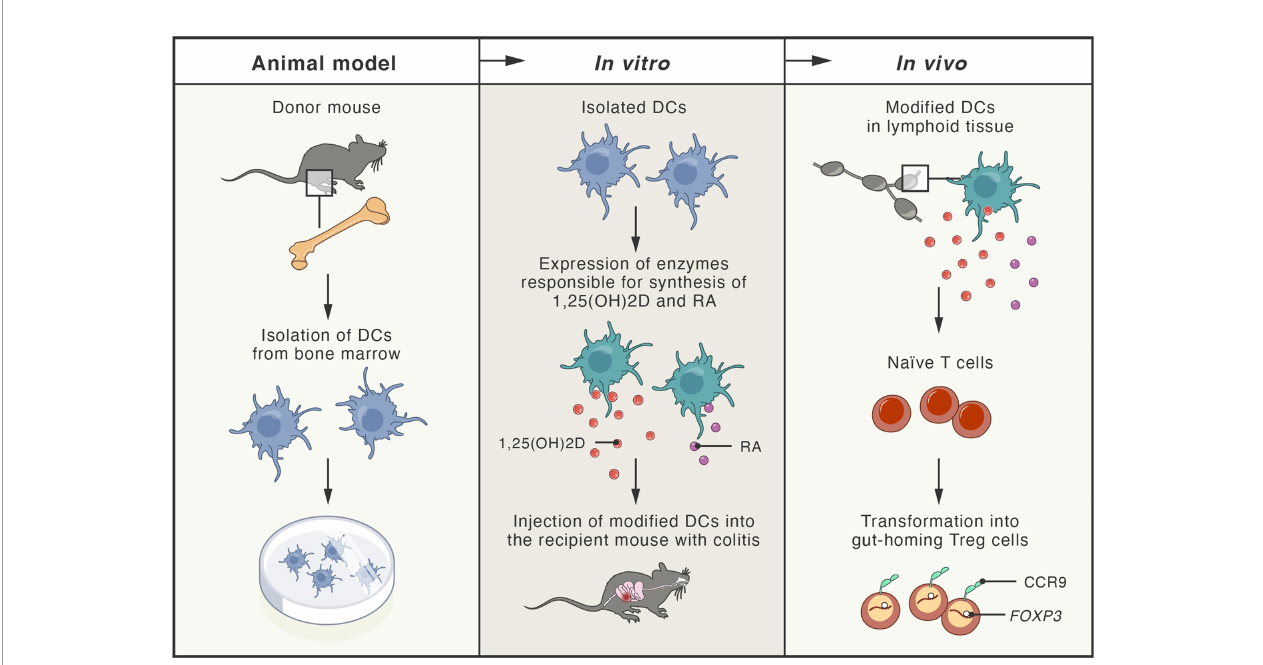
FIGURE 5 | Schema of new therapeutic approach tested in mouse models of colitis. Dendritic cells (DCs) obtained from the bone marrow of donor mice were genetically modi fi ed to express enzymes responsible for production of 1,25-dihydroxyvitamin D (1,25(OH) 2 D; active vitamin D metabolite) and retinoic acid (RA; active vitamin A metabolite). Modi fi ed DCs were transferred to the recipient mice with experimentally-induced colitis. In peripheral lymphoid tissues, 1,25(OH) 2 D and RA (produced by the modi fi ed DCs), induced naïve T cells transformation into gut-homing regulatory T cells (Treg), by induction of FOXP3 and CCR9 (gut-homing receptor). T reg cells ef fi ciently homed to the intestine, where they inhibited in fl ammation and